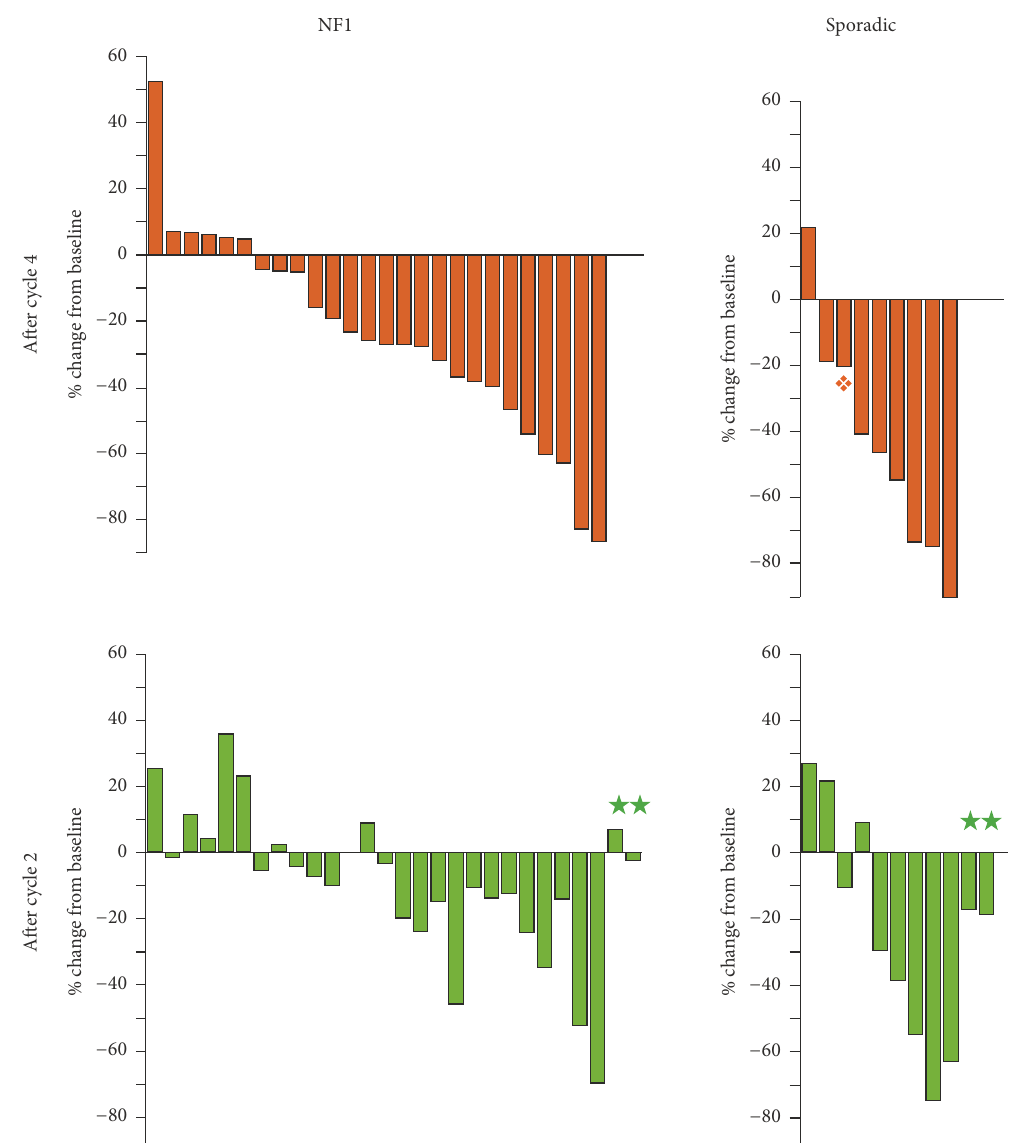
Figure2:Waterfallplotsshowingchangein2-dimensionaltumormeasurementsaccordingtoWHOcriteriaafter4cycles(2cyclesifosfamide and doxorubicin, IA, and 2 cycles of ifosfamide and etoposide, IE, upper panels) and 2 cycles (IA, lower panels). On all four panels patients are arranged by best response measured after cycle 4. ‰ Patients removed from treatment after cycle 2. j Target lesion stable, but progressive disease with new